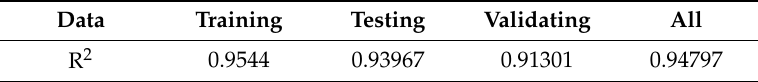
Table 2. Characteristics of the ANN model for the first dataset.